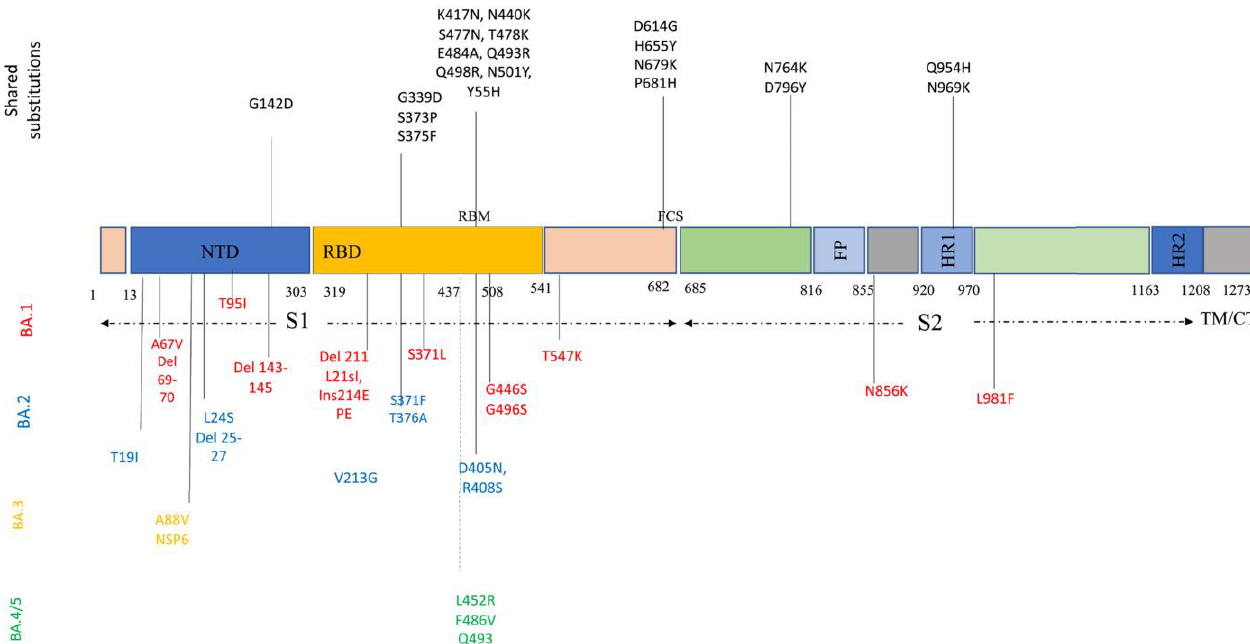
Figure 2. Amino acid substitutions within the Omicron variant lineage. Black color represents shared mutations, red Omicron BA.1, blue BA.2, orange BA.3, and green BA.4/BA.5. BA.4 and BA.5 share a similar spike profile as BA.2, except for additional mutations 69 – 70del, L452R, F486V (green) and reversions to wild type Q493 (Q493R in BA.1, BA.2, and BA.3). BA.4 and BA.5 differ from each other by three amino acid mutations outside Spike. BA.4 additional mutations: ORF7b:L11F, N:P151S. BA.5 additional mutations: M:D3N [36].